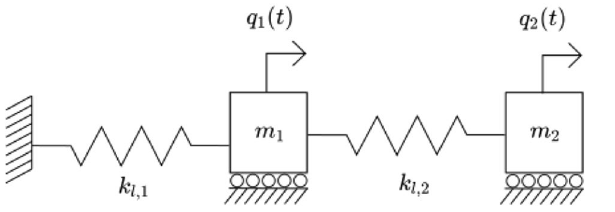
Figure 6. Autonomous 2DOF system.